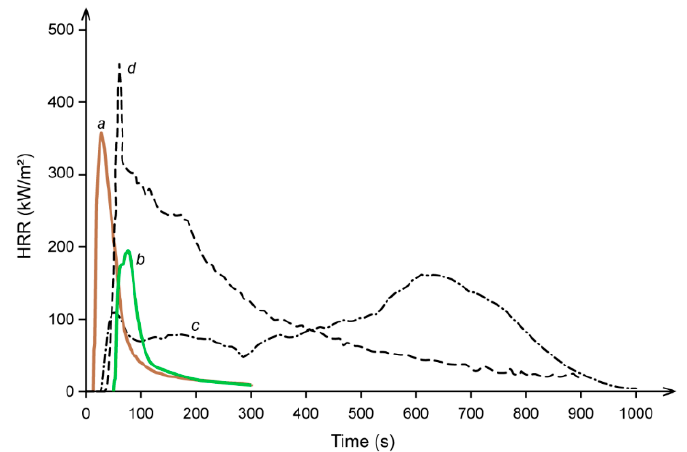
Figure 4. Comparison of HRR of vegetation parts of gorse shrub and typical roof coverings: ( a ) dead parts with dried leaves and twigs (redrawn from Madrigal et al. [58]); ( b ) green leaves (redrawn from Madrigal et al. [58]); ( c ) PMB membrane with fire retardants (redrawn from Bourbigot et al. [49]); ( d ) PMB membrane without fire retardants (redrawn from Thureson and Nilsson [48]).